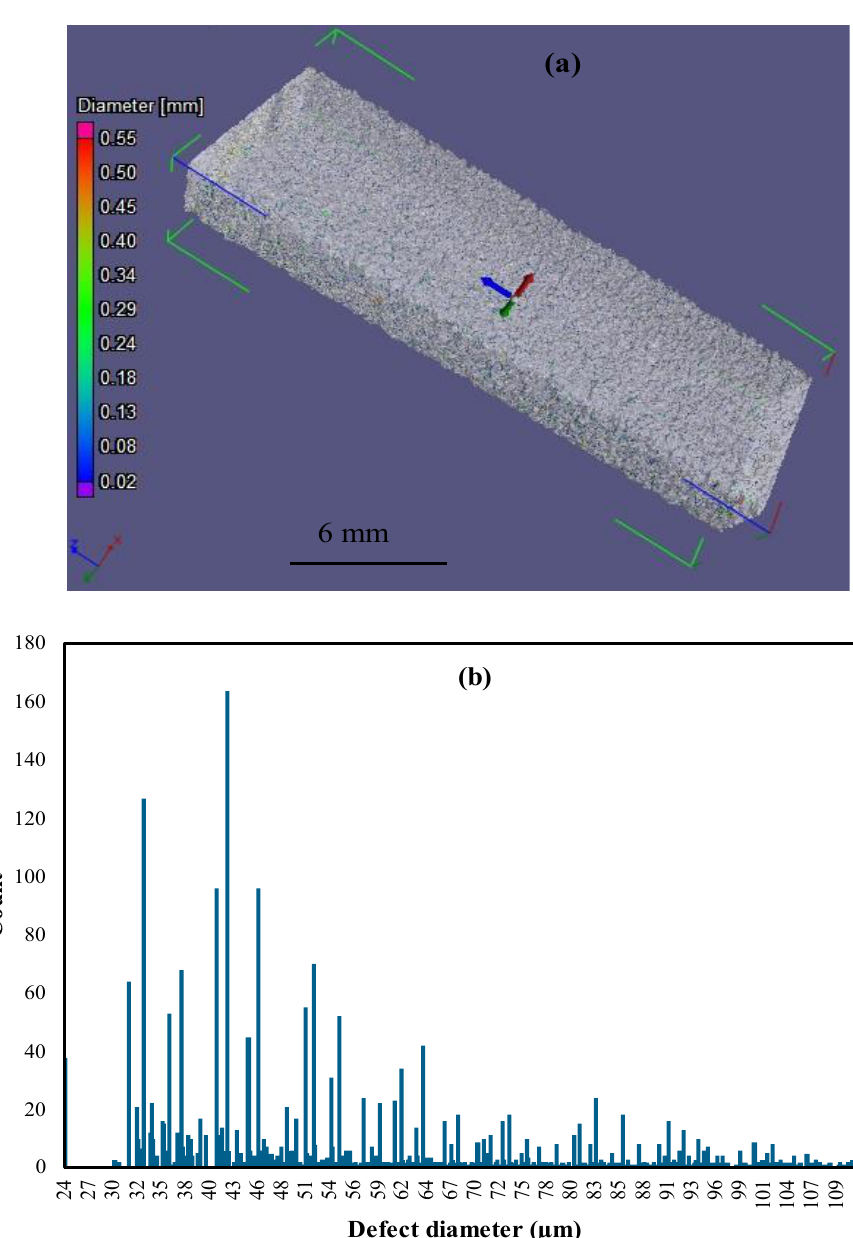
Figure 5. Defect distribution on the top-built sample, obtained from X-ray CT analysis: ( a ) 3D defect distribution inside the sample, and ( b ) frequencies of the distributed defects.